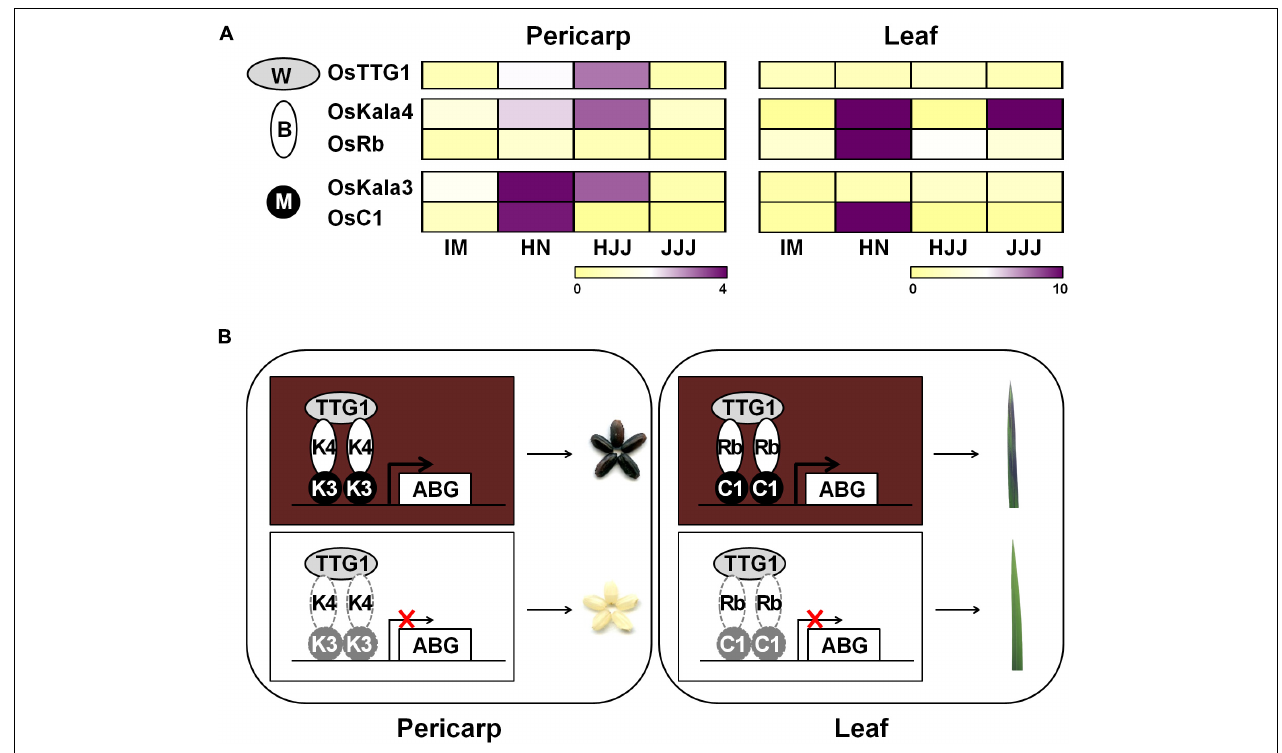
FIGURE 8 | Proposed model of anthocyanin biosynthesis of seed and vegetative tissue in rice. (A) Heat map diagram of expression level for anthocyanin regulators consisting of MYB (M), bHLH (B), and WD40 (W) from rice pericarp and leaf, respectively. Color scale indicates fold changes in gene expression. (B) Working models of anthocyanin coloration in different tissues of rice. Both OsKala3 and OsKala4 had extremely high expression levels in rice pericarp, while OsC1 and OsRb were more strongly expressed in respective rice leaf. When all of OsDFR was functional, it forms the functional MBW complex consisting of OsKala3-OsKala4-OsTTG1 and OsC1-OsRb-OsTTG1 activating anthocyanin biosynthesis in